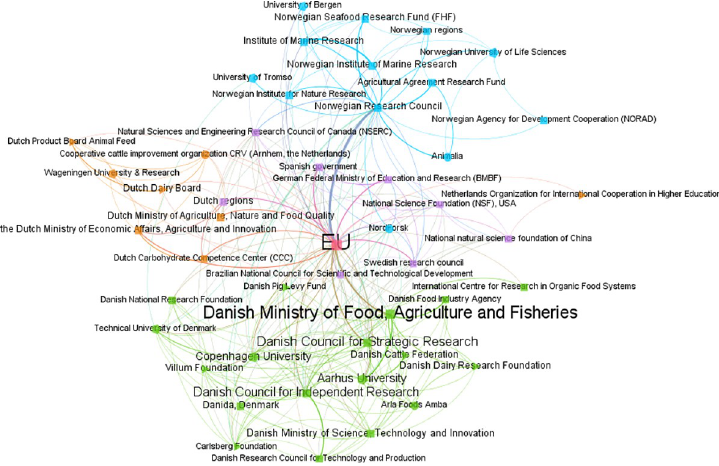
Fig 4. Food Science co-funding network, all affiliation countries. Origin colours: Green = affiliated-Denmark; orange = affiliated-Netherlands; blue = affiliated-Norway; purple = affiliated other countries; red = supranational. Other labels as per Fig